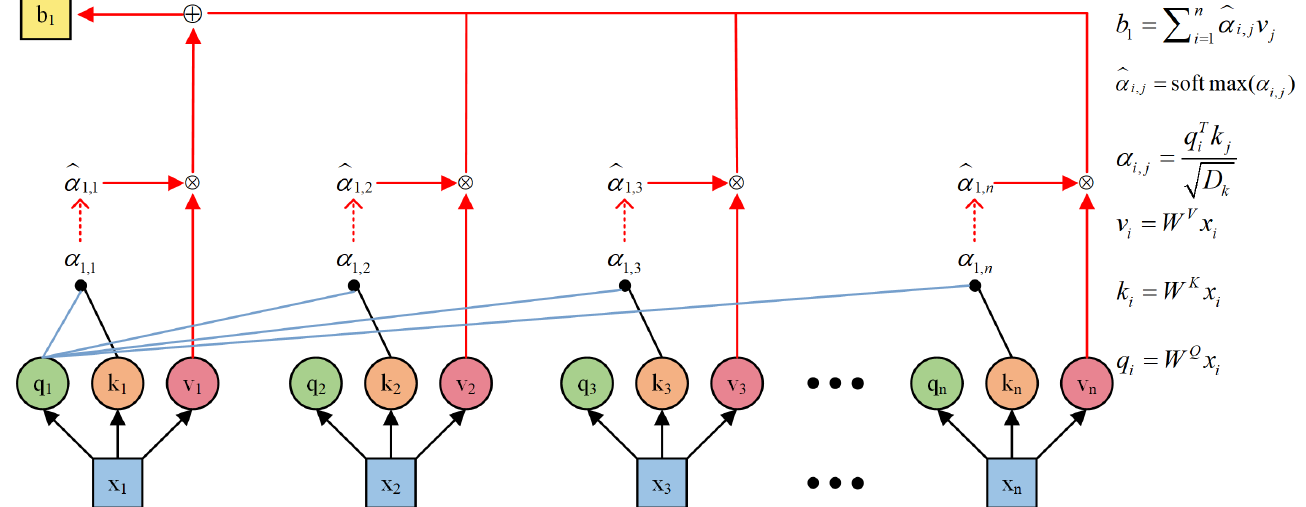
Figure 3. The process of obtaining b 1 in the output sequence B from the input sequence X by self-attentive computation.